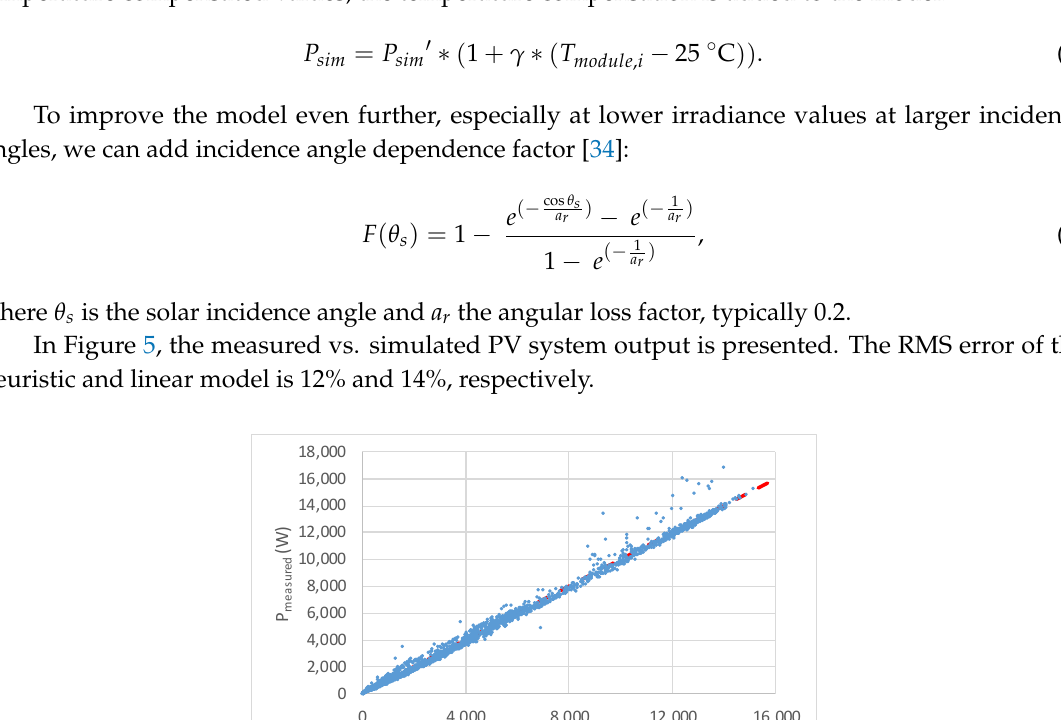
Figure 6. LPVO PV system on the roof of Faculty of Electrical Engineering in Ljubljana.